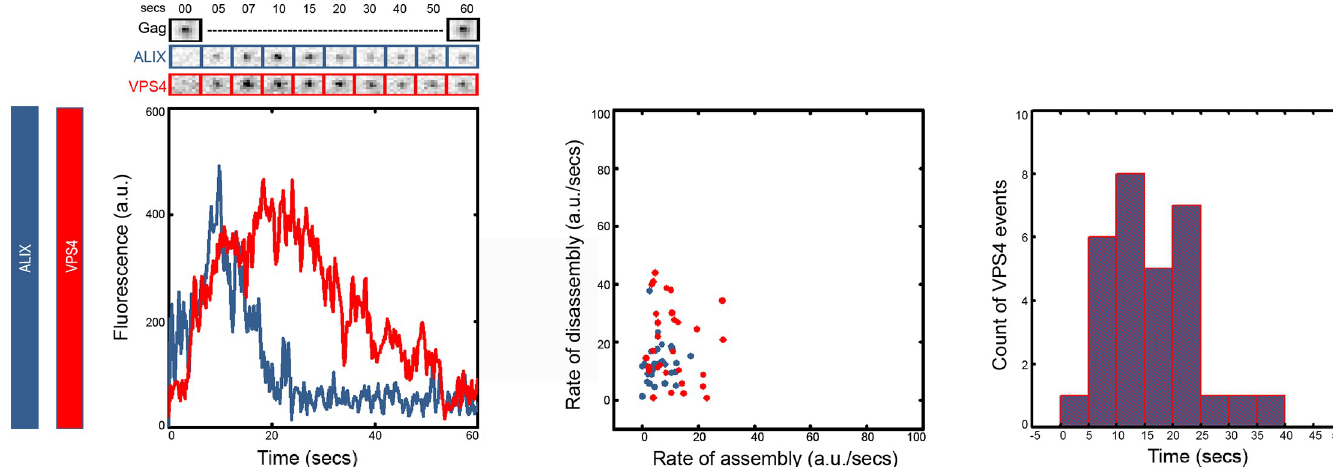
Fig 1. ALIX is disassembled in the presence of VPS4. The left graph shows the intensity plot of ALIX (Blue) and VPS4 (Red) and cropped TIRF images of the Gag (topmost, Black), ALIX (middle, Blue) and VPS4 (bottom, Red). The scatter plot in the middle panel shows the rate of assembly and disassembly for ALIX and VPS4. The histogram on the right panel shows the distribution of the retention time of VPS4. (Rates of assembly/disassembly as well as the retention time are defined in S2 Fig).